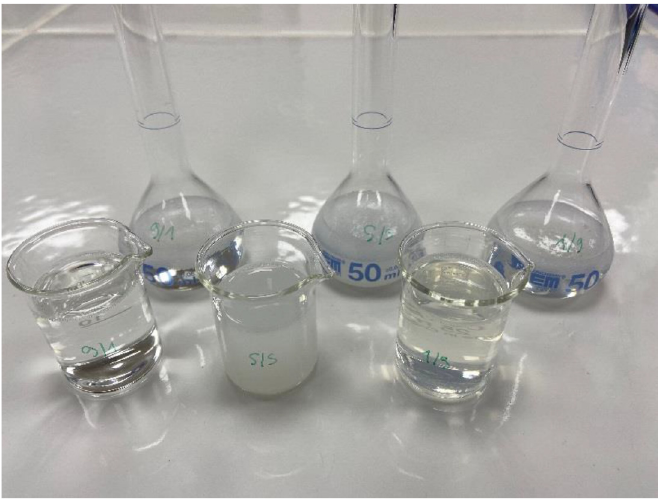
Figure 1: The amiodarone hydrochloride – cefazolin sodium pair was whitish at the 1/1 ratio (in the middle) and opalescent at the 1/9 ratio (right) at T 0H.